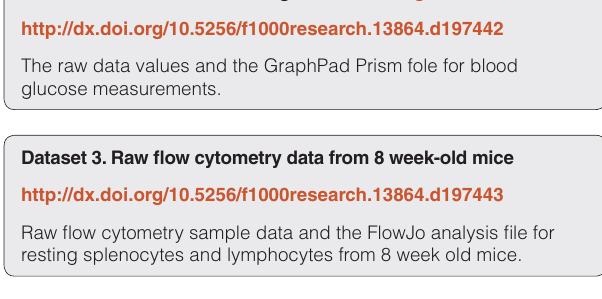
Dataset 4. Raw flow cytometry data from ex vivo stimulated splenocytes